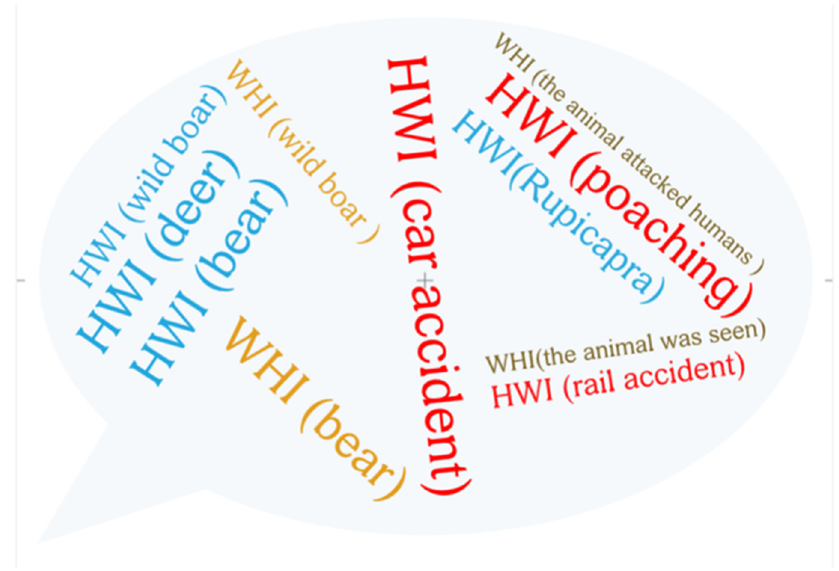
Figure 1. Word cloud representations for HWI (Human-Wildlife-Interactions) and WHI (Wildlife- Human-Interactions).